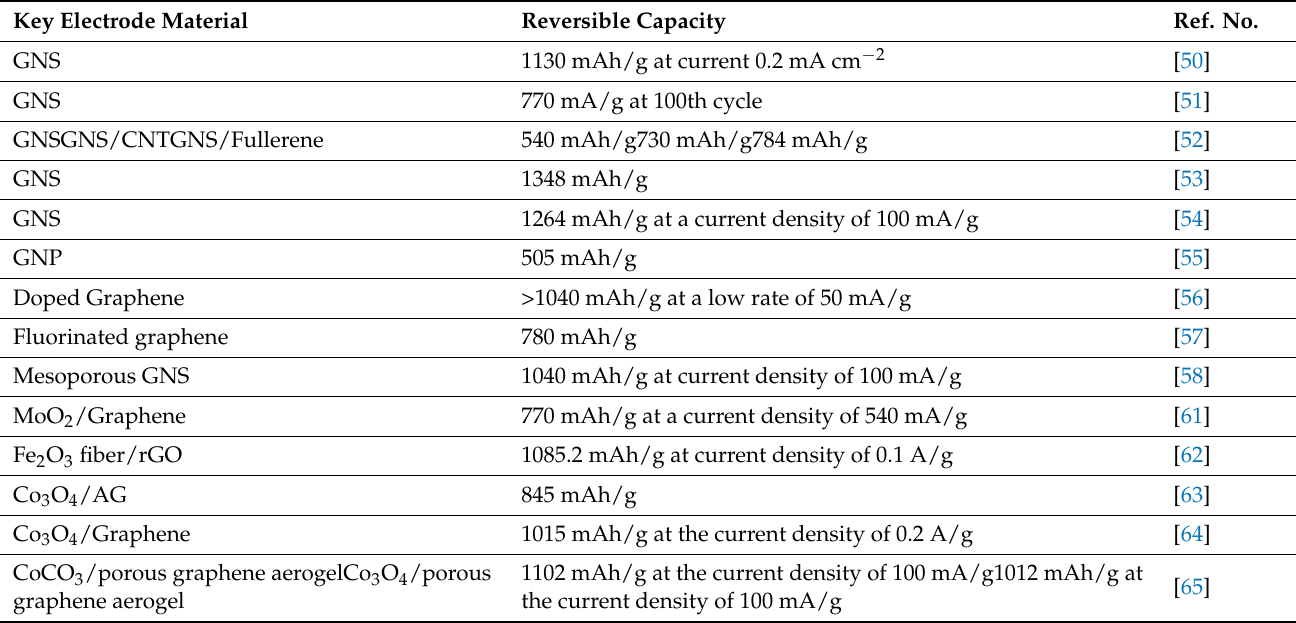
Table 1. The different electrode materials used for capacity enhancement of LIBs in the last